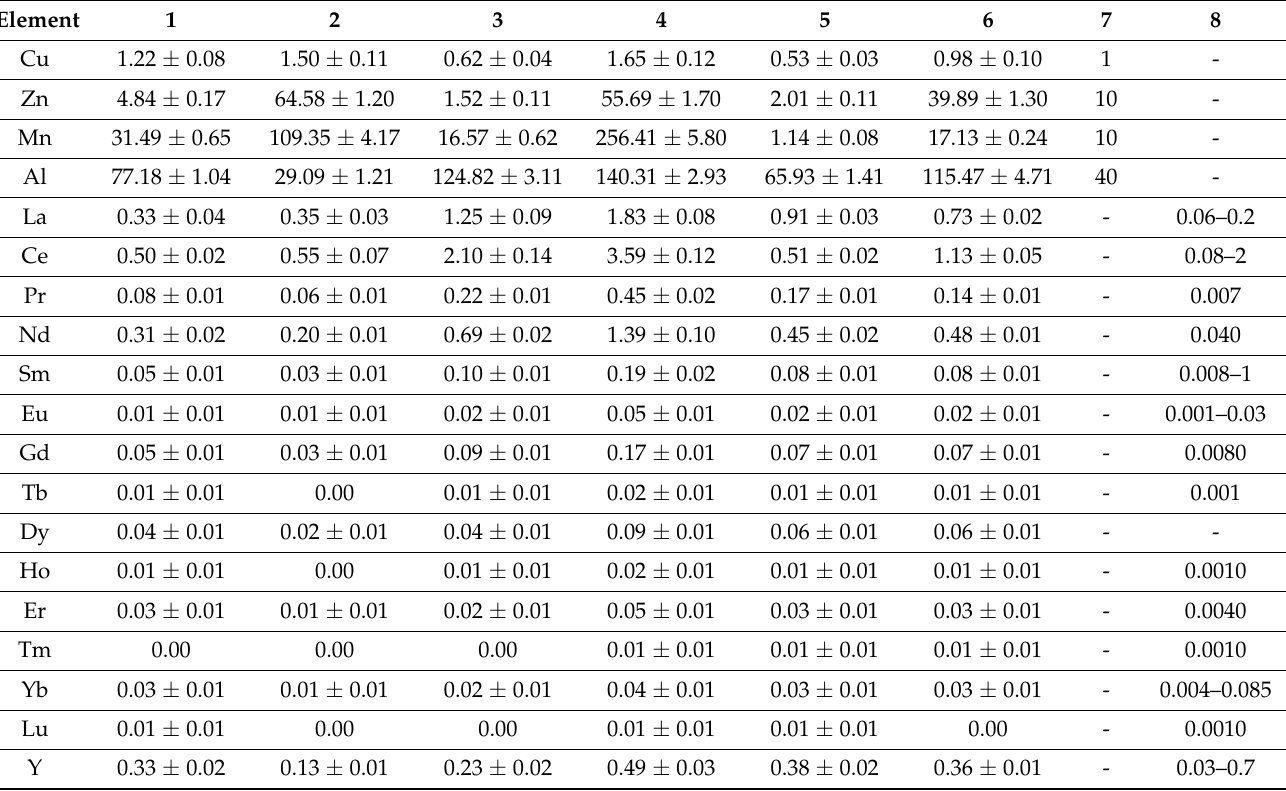
Table 3. Concentrations of elements in surface water samples, µ